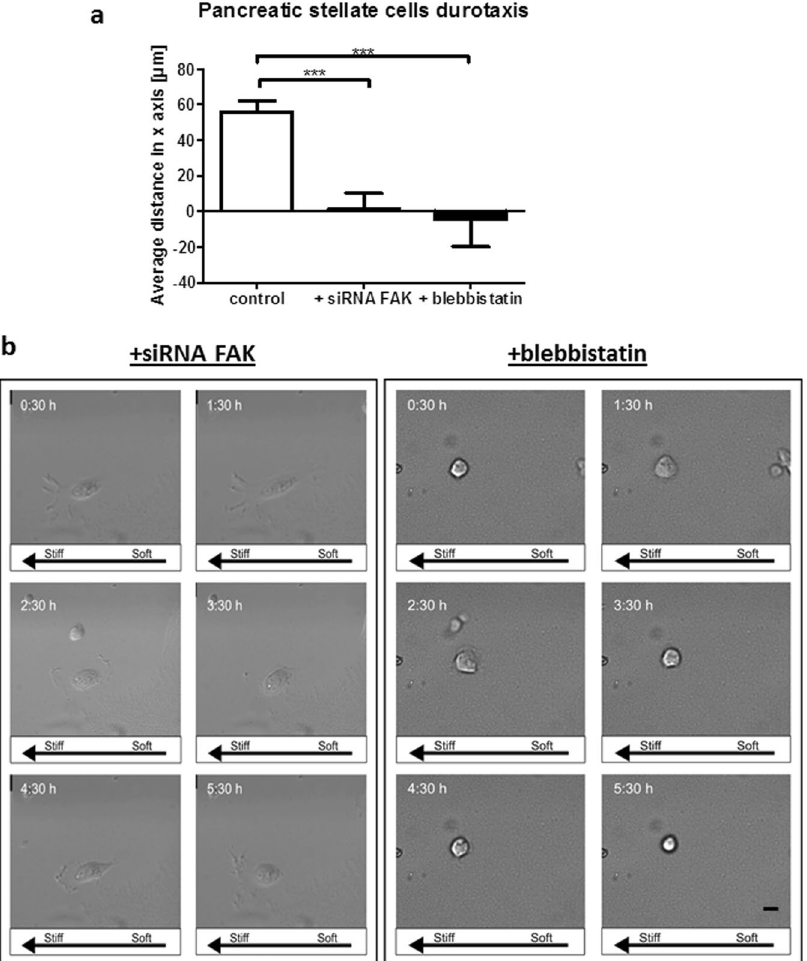
Figure 5. FAK and myosin-II activities are required for durotaxis in PSCs. ( a ) Average cell migration distance at the rigidity boundary over a 12-hour period for control PSCs, PSCs transfected with siRNA for FAK, and PSCs treated with blebbistatin. Positive values indicate movement towards higher rigidity, values close to 0 indicate random, undirected movement. Histogram bars represent mean ± SEM. *** p < 0.001. ( b ) Representative images of PSC migration over a 5 h period. Scale bar 25 μ